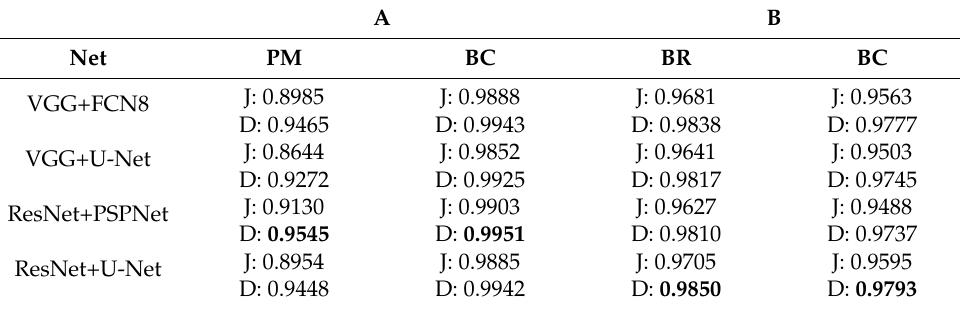
Table 7. Segmentation metrics for experiments A and B. Best results in bold. A